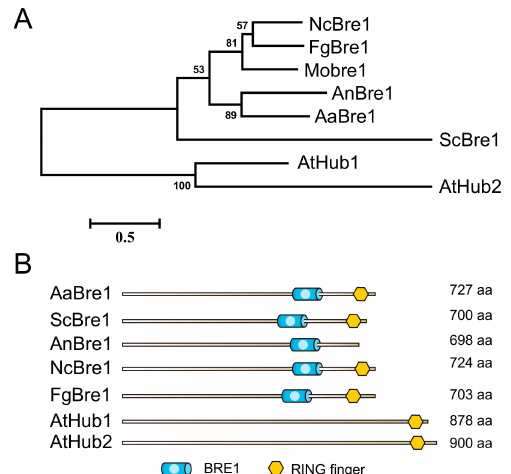
Figure 1. Identification of E3 ligase AaBre1 in A. alternata . ( A ) Phylogenetic analysis of Bre1 homologues in several organisms. The alignment was performed with ClustalW2 and the MEGA program, version 5.1, was used for a phylogenetic analysis using the maximum-likehood tree method. Neurospora crassa (Nc); Aspergillus nidulans (An); Saccharomyces cerevisiae (Sc); Arabidopsis thaliana (At). ( B ) Domains